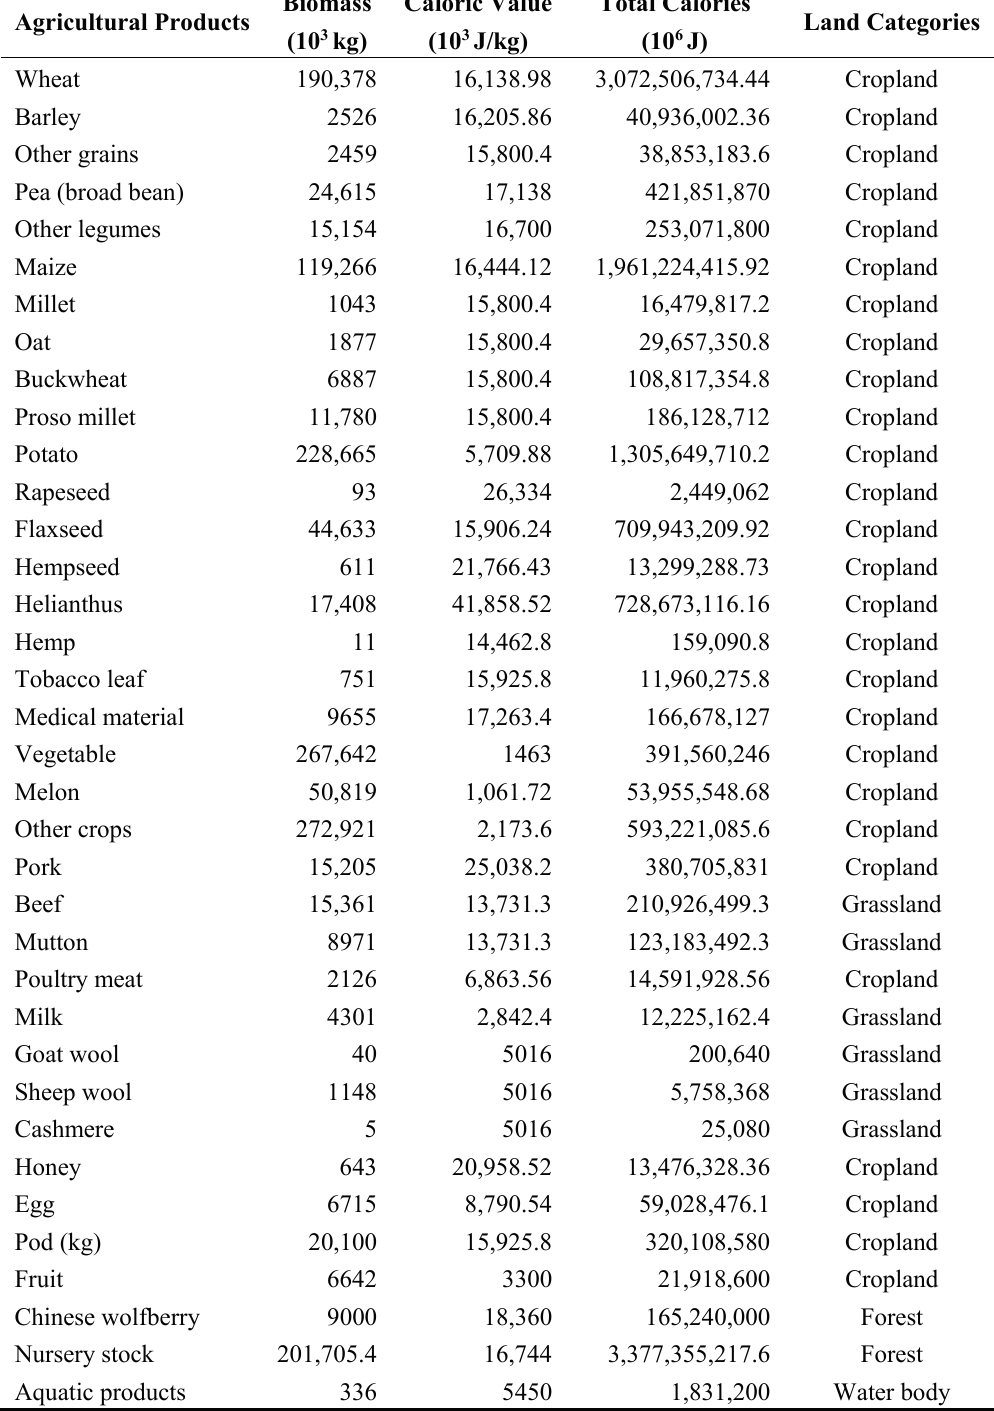
Table A1. Main biological production of Guyuan used to calculate the equilibrium factor in 2012. Agricultural